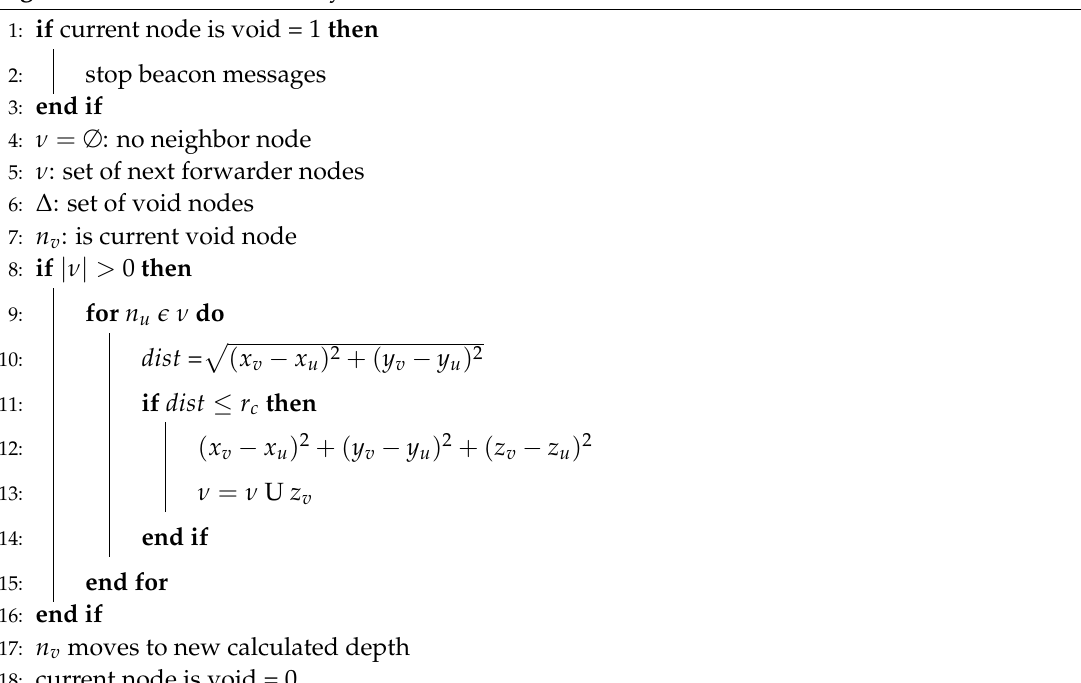
Algorithm 4 Void hole recovery for